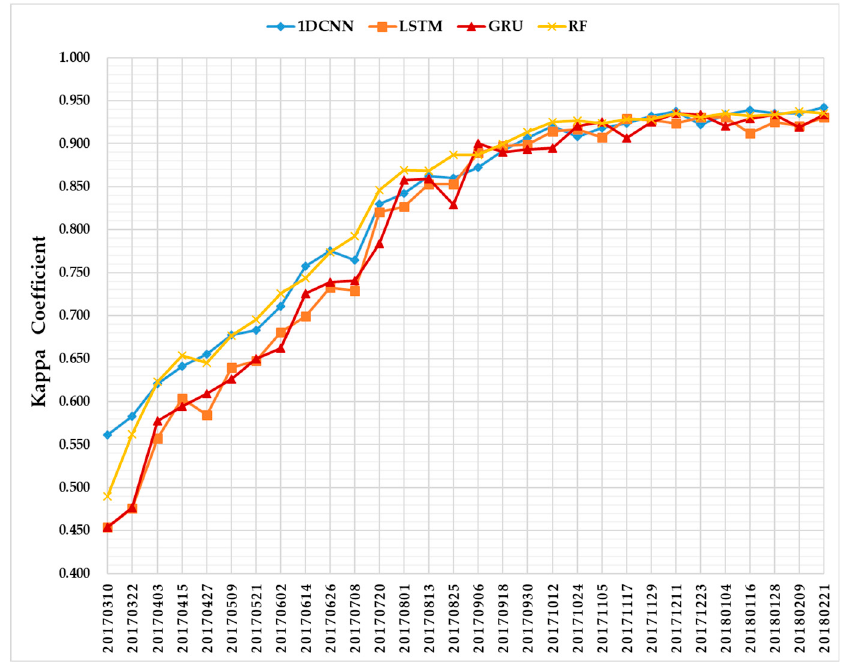
Figure 11. Kappa coefficient profiles of the four classifiers. Table 4. A summary of Kappa coefficients and the overall accuracies of the different classifiers. Bolded dates and values are the best results.